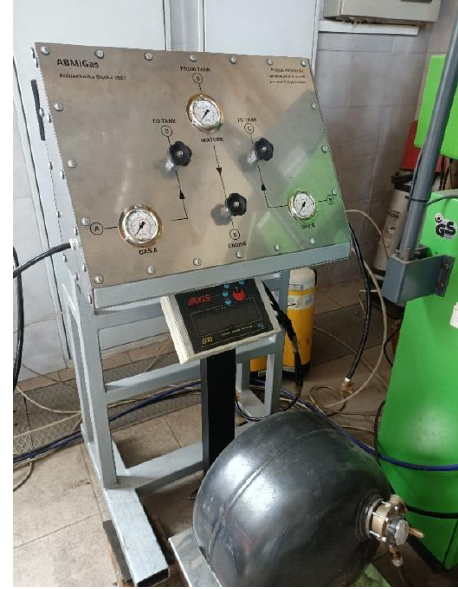
Fig. 2. Station for the production of gas